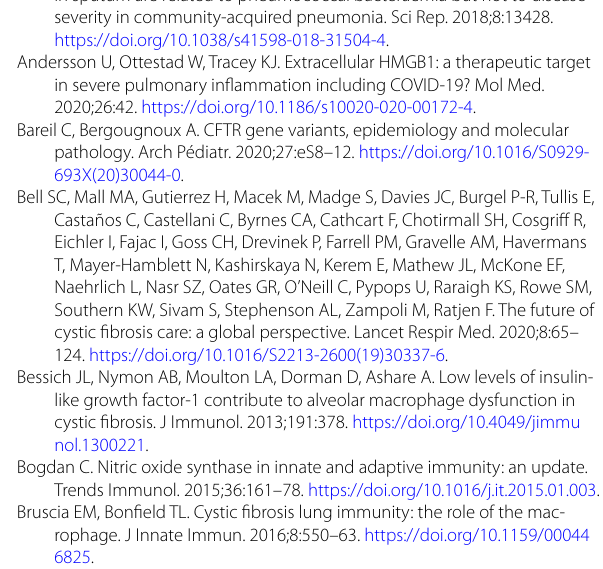
Figure 2. ODSH does not significantly improve intrinsic phagocytic ability of macrophages in CF